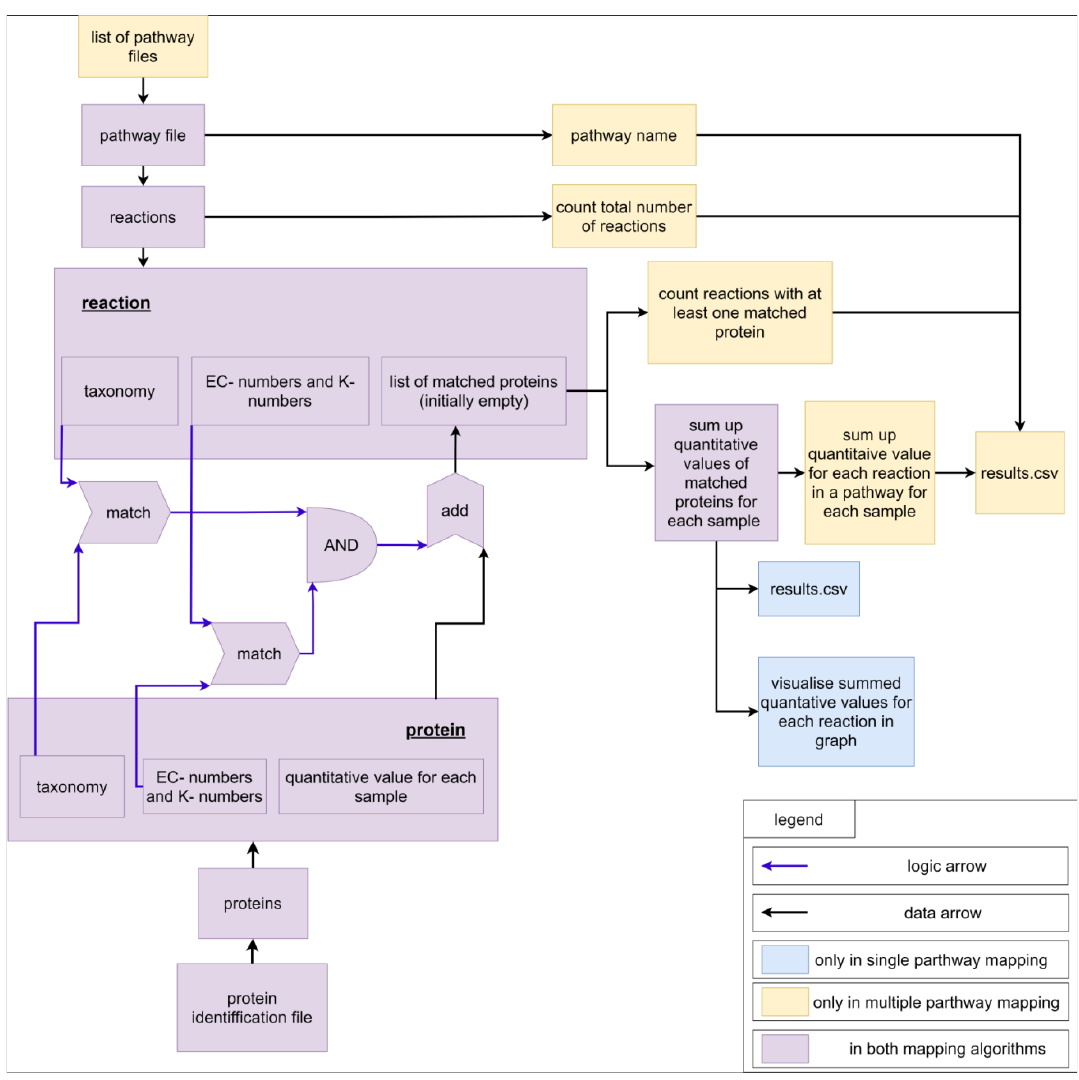
Figure 7. Scheme for visualization of the mapping algorithm.